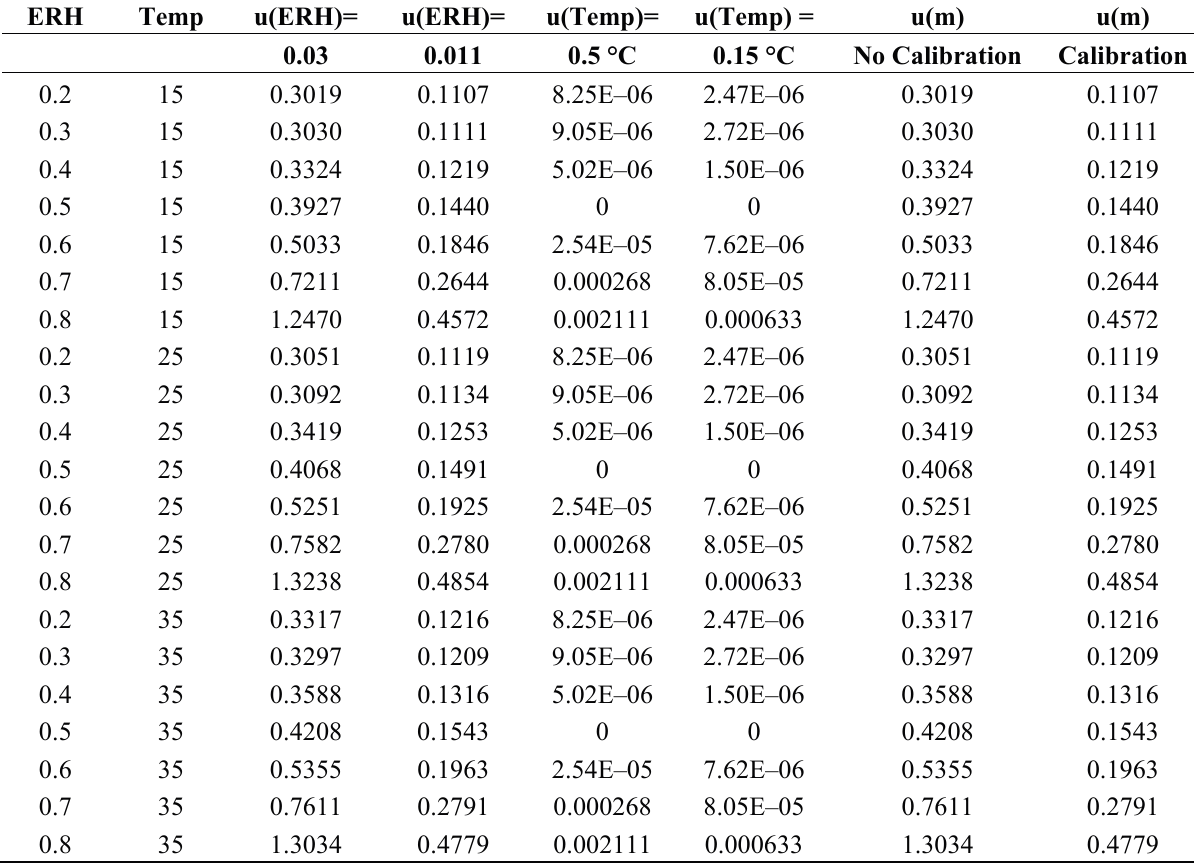
Table 5. The calculation results of the uncertainty for moisture content by ERH technique at seven RH levels and three temperatures.